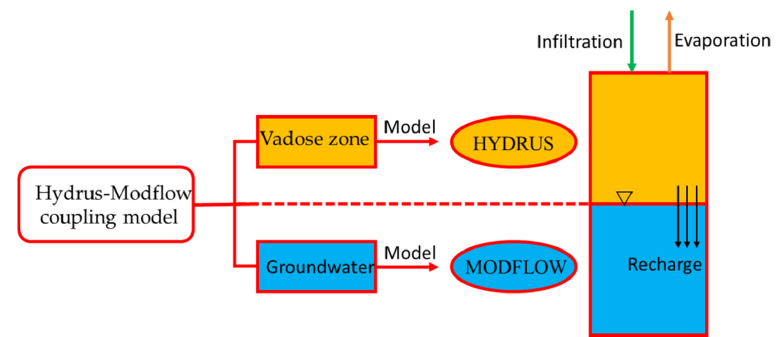
Figure 1. Schematic diagram of the HYDRUS-MODFLOW coupling principle.